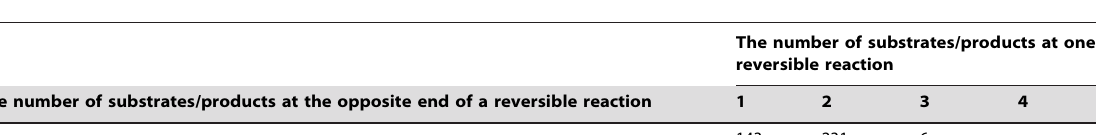
Table 2. The distribution of reversible reactions classified by their numbers substrates/products.